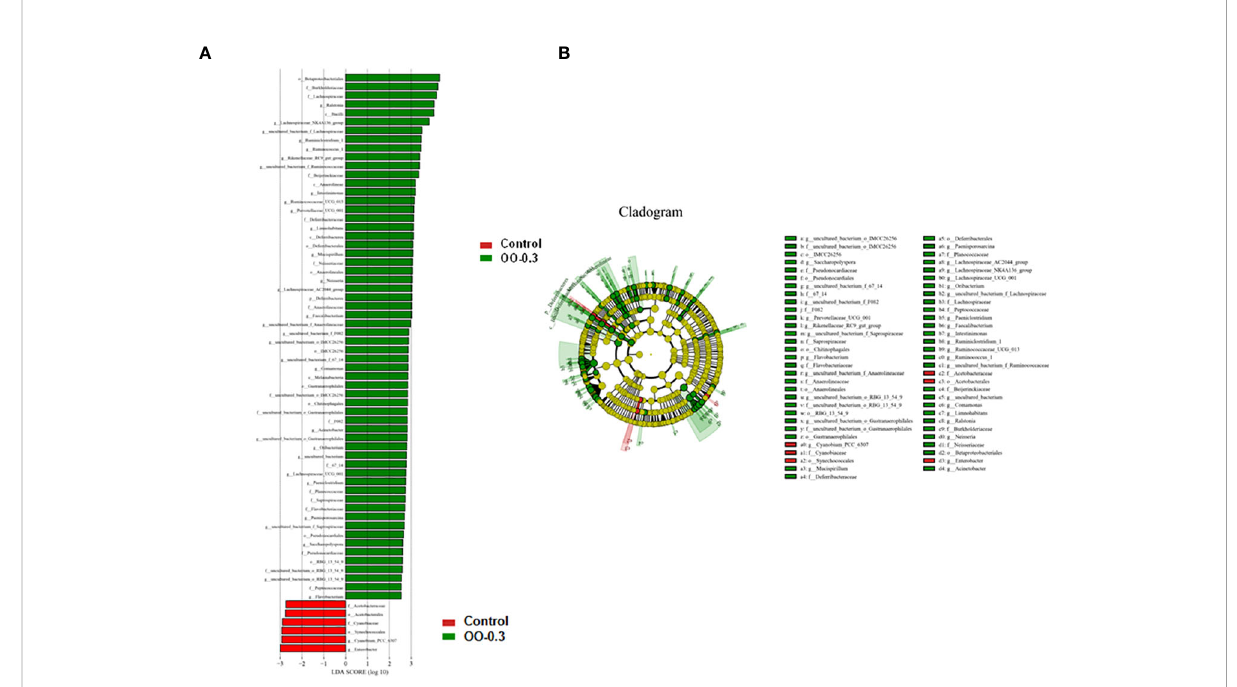
FIGURE 7 Effect of dietary oregano oil (OO) on the differences in the intestinal microbiota of juvenile hybrid grouper fed the control and OO-0.3 diets for 8 weeks. (A) The linear discriminant analysis score of the abundance of taxa. (B) Cladogram showing differences in the abundance of taxa (phylum to genus) in the intestinal